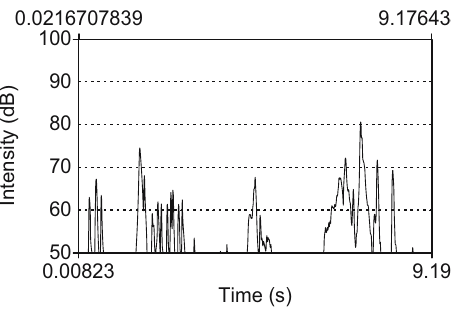
Figure 1: PRAAT - Graphic showing the intensity of laughter in the fi rst excerpt.